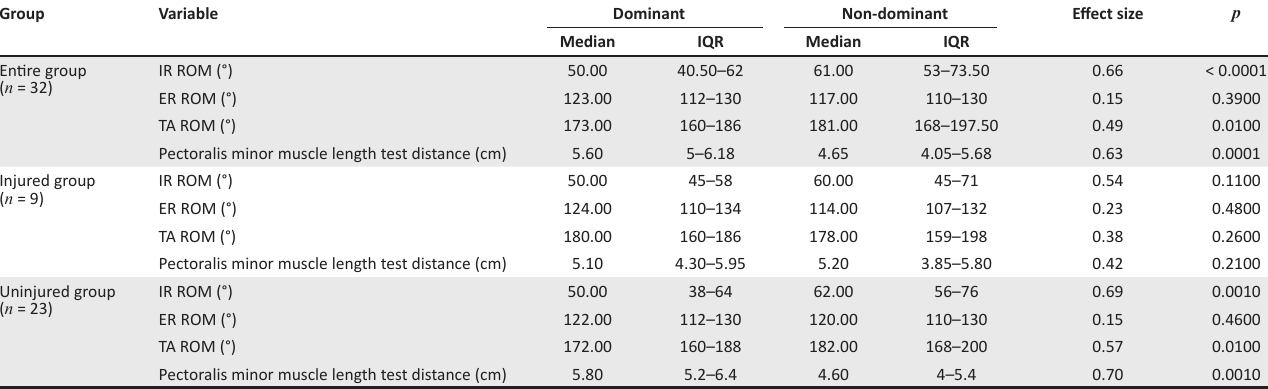
TABLE 2: A comparison between the dominant and non-dominant shoulder in the entire group, injured and uninjured group. Group